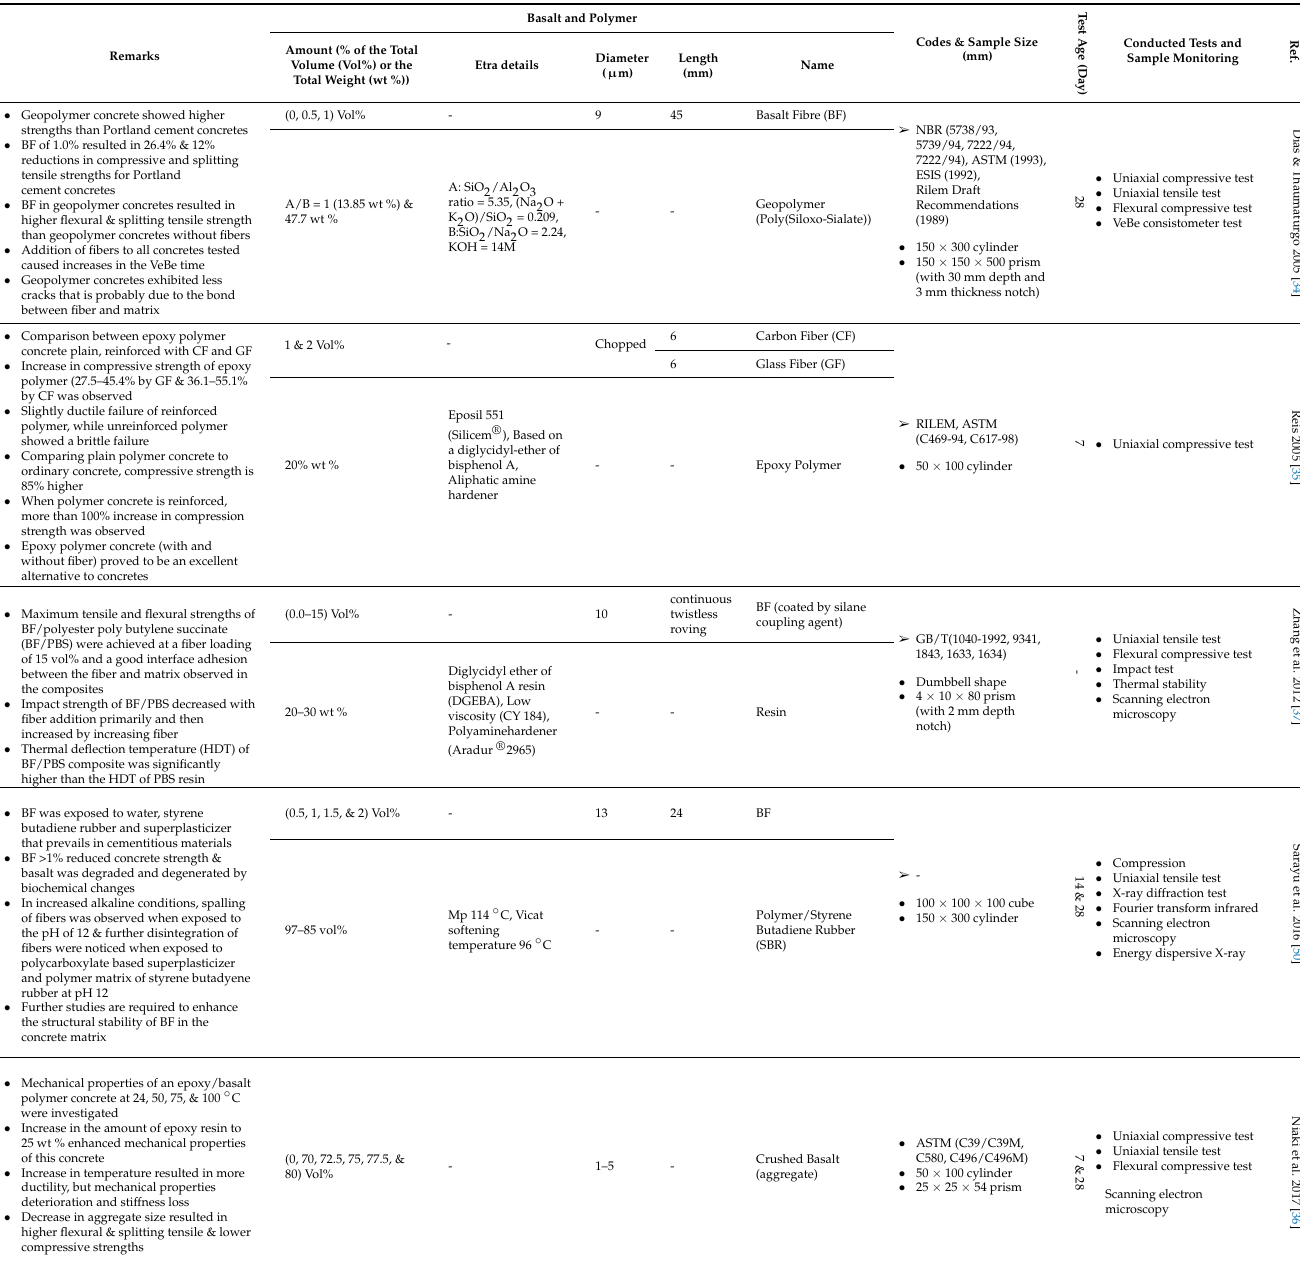
Table 4. Polymer concrete (PC)/polymer-Portland cement concrete (PPCC) with